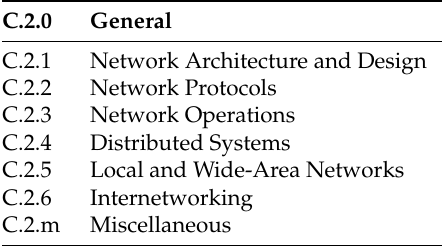
Table 4. ACM Classification: Topic C.2—Computer-Communication